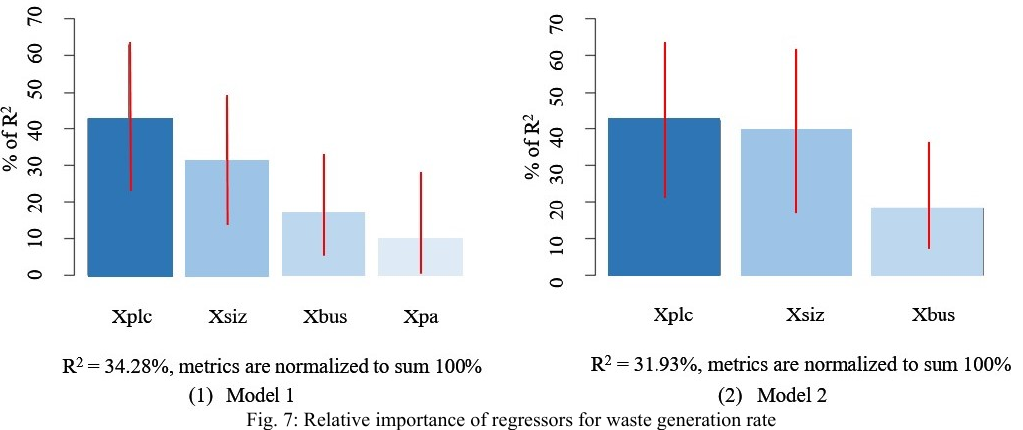
Fig. 7: Relative importance of regressors for waste generation rate